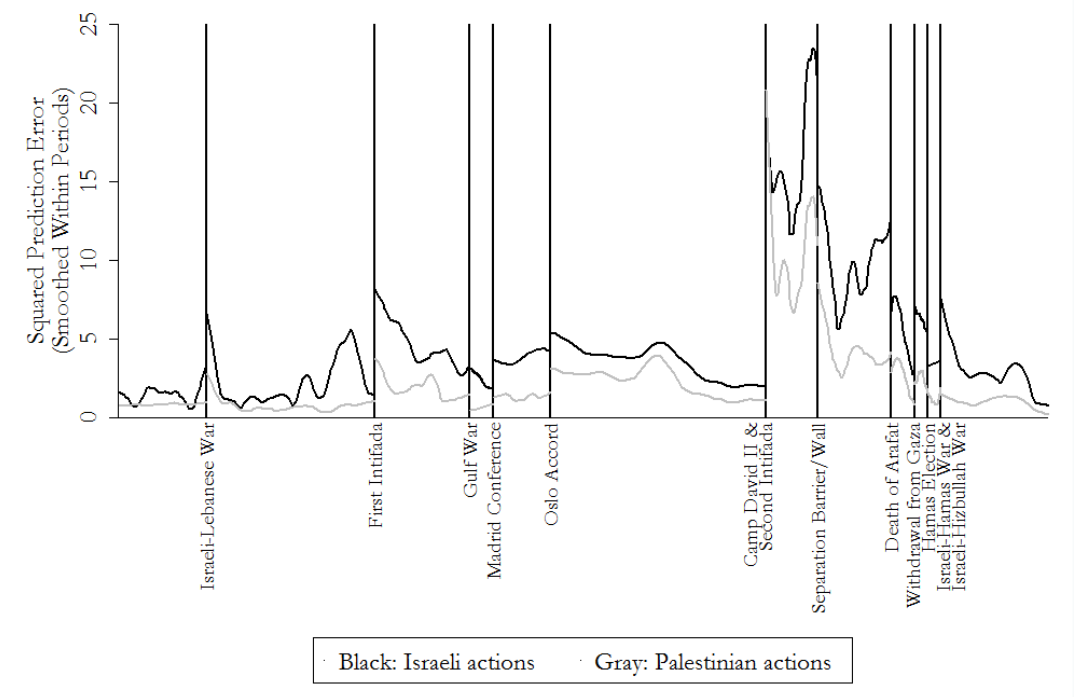
Figure 3: Israeli-Palestinian Interactions: Squared Prediction Error, 1979-2009. Out-of-sample predic- tion error leapt at many historic episodes in Israeli-Palestinian interaction. Note: Events within three months of each other are displayed in this chart as a single line: Camp David II and the Second Legend: Out-of-sample prediction error leapt at many historic episodes in Israeli-Palestinian Intifada in 2000; Israeli-Hamas War and Israeli-Hizbullah War in interaction.